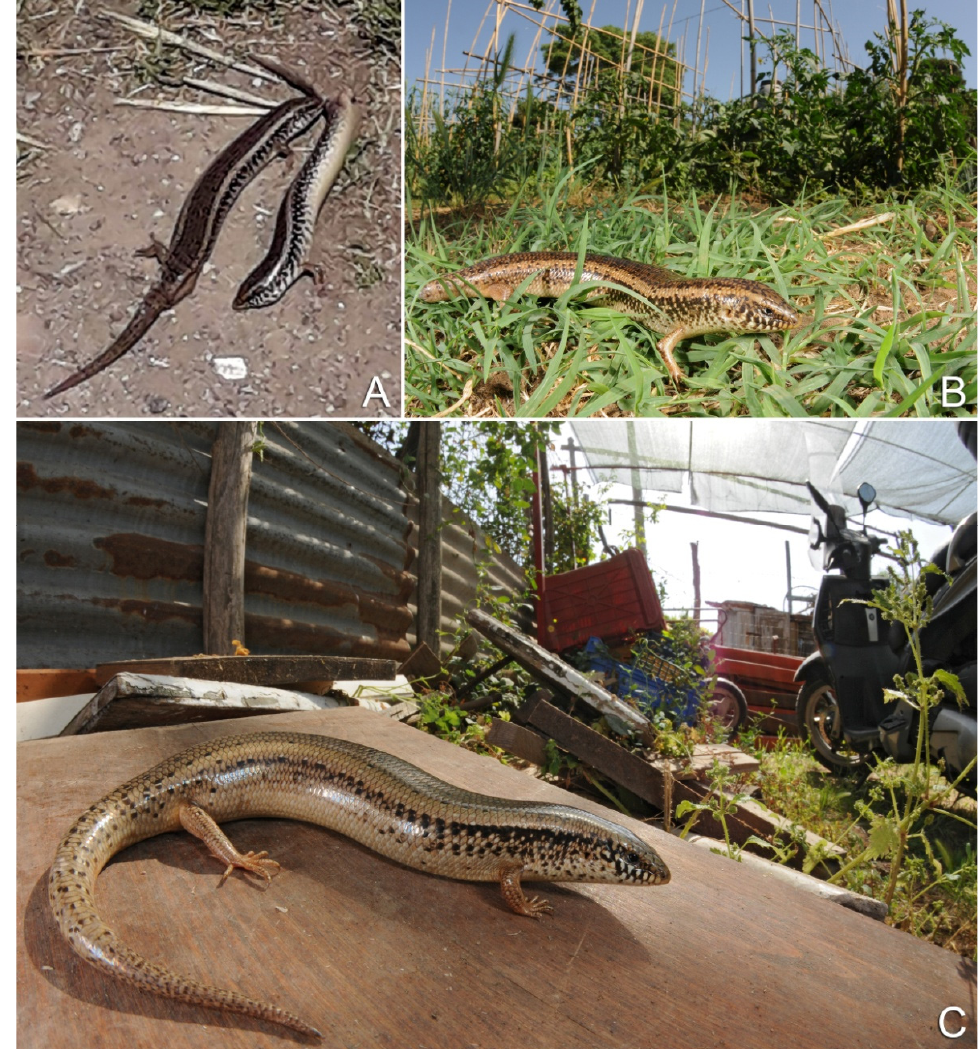
Figure 1. ( A ) the first photograph documenting the ocellated skink in Tuscany (© Ugo Preziosi); ( B , C ) individuals of this species found in the surroundings of Piombino port (province of Livorno, Central Italy, © Matteo Riccardo Di Nicola).